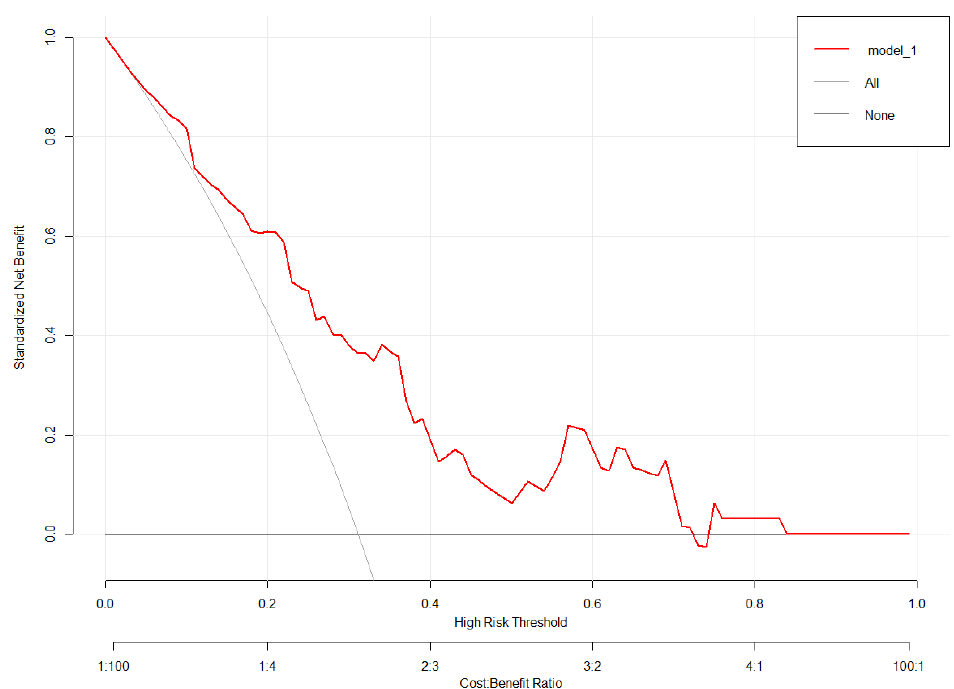
Figure 6. The decision curve analysis diagram of the